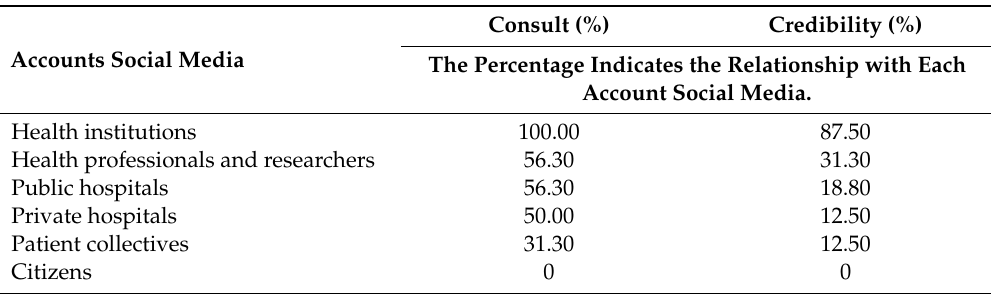
Table 9. Health-related social